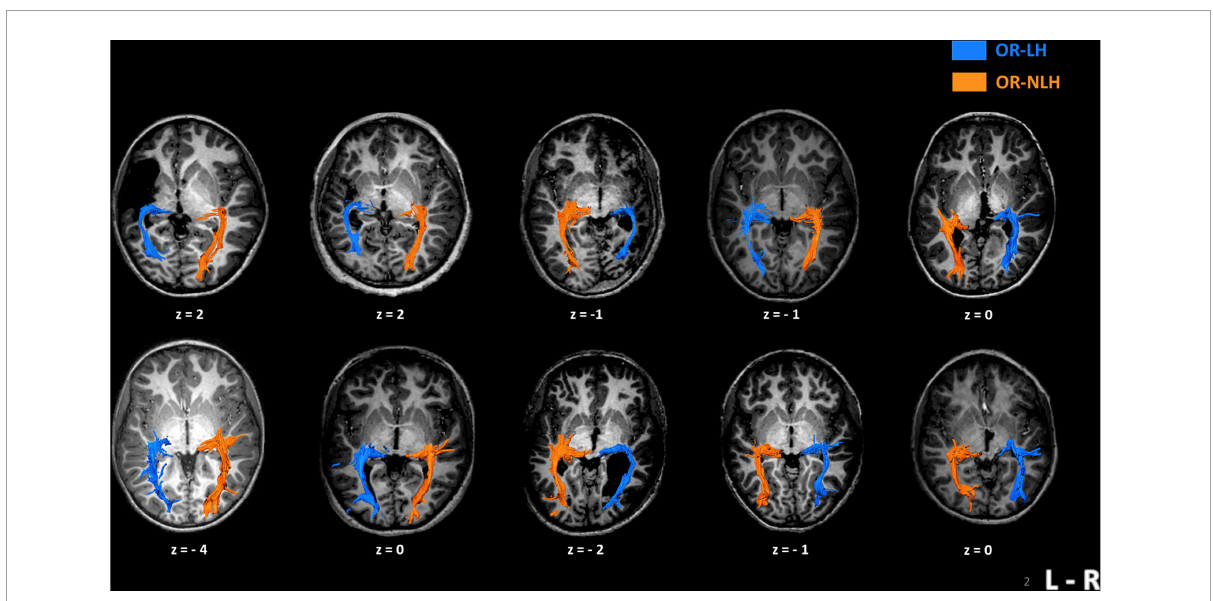
FIGURE2 Imaging results in 10 children with unilateral spastic cerebral palsy, displaying their individual optic radiation bypasses. The upper row shows examples of children with cortico-subcortical lesions and the lower row depicts children with periventricular lesions. Z -values represent the coordinates in Talairach space. OR-LH, optic radiation of the lesional hemisphere; OR-NLH, optic radiations of the non-lesional hemisphere; L-R,